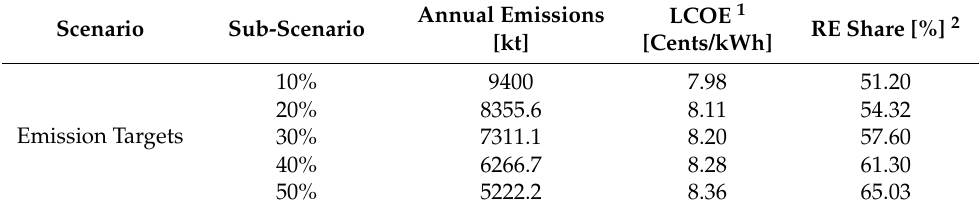
Table 8. Sensitivity analysis of emission reduction targets in 2035.